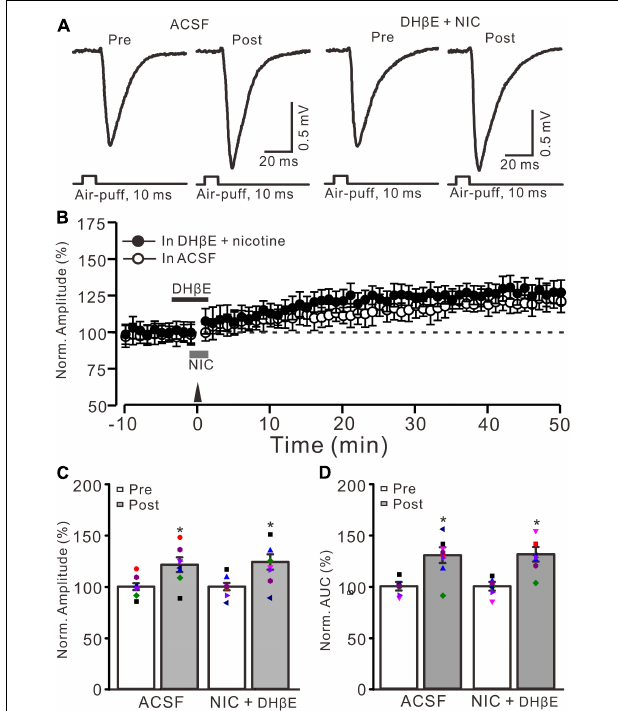
FIGURE 3 | Nicotine-induced enhancement of MF-GrC LTP was abolished by α 4 β 2 antagonist. (A) Representative extracellular recording traces illustrating facial stimulation (10 ms, 60 psi)-evoked MF-GrC synaptic response in a mouse cerebellar cortex before and after delivering 20 Hz (240 pulses) stimulation in the absence (ACSF) and the presence of a mixture of α 4 β 2-nAChR blocker, DH β E (1 µ M), and nicotine (NIC; 1 µ M). (B) Summary of data showing the time course of normalized amplitude of the response before and after delivery of 20 Hz facial stimulation (arrow head) in the absence (ACSF, open circle) and the presence of a mixture of Dh β E (black bar) and nicotine (NIC; gray bar) (filled circle). (C) Bar graph showing normalized amplitude of the response before (pre) and after (post) delivery of 20 Hz facial stimulation in the absence and the presence of a mixture of DH β E and nicotine. (D) Pooled data showing normalized AUC of the response before (pre) and after (post) delivery of 20 Hz facial stimulation in the absence and the presence of a mixture of DH β E and nicotine. Note that nicotine failed to enhance the facial stimulation-evoked MF-GrC LTP in the presence of α 4 β 2 nAChR antagonist. Data points are mean ± S.E.M. n = 8 recordings from 8 mice in each group. * P < 0.05 vs. post.